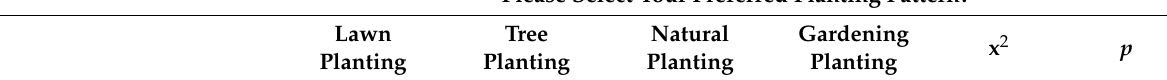
Natural Planting